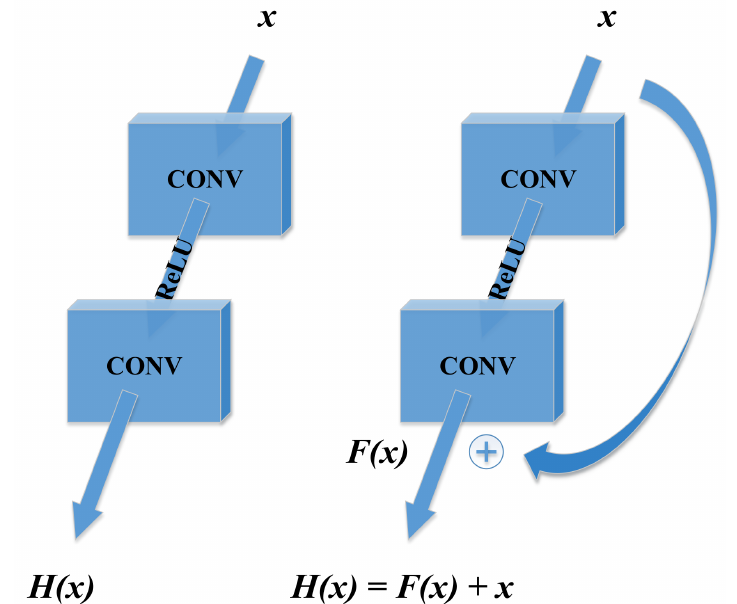
Figure 3. A regular block ( left ) and a residual block ( right ). A combination of HSI and deep learning in the past was restricted by datasets and the effective features of the one-dimensional convolution extraction model. Thus, in this study,